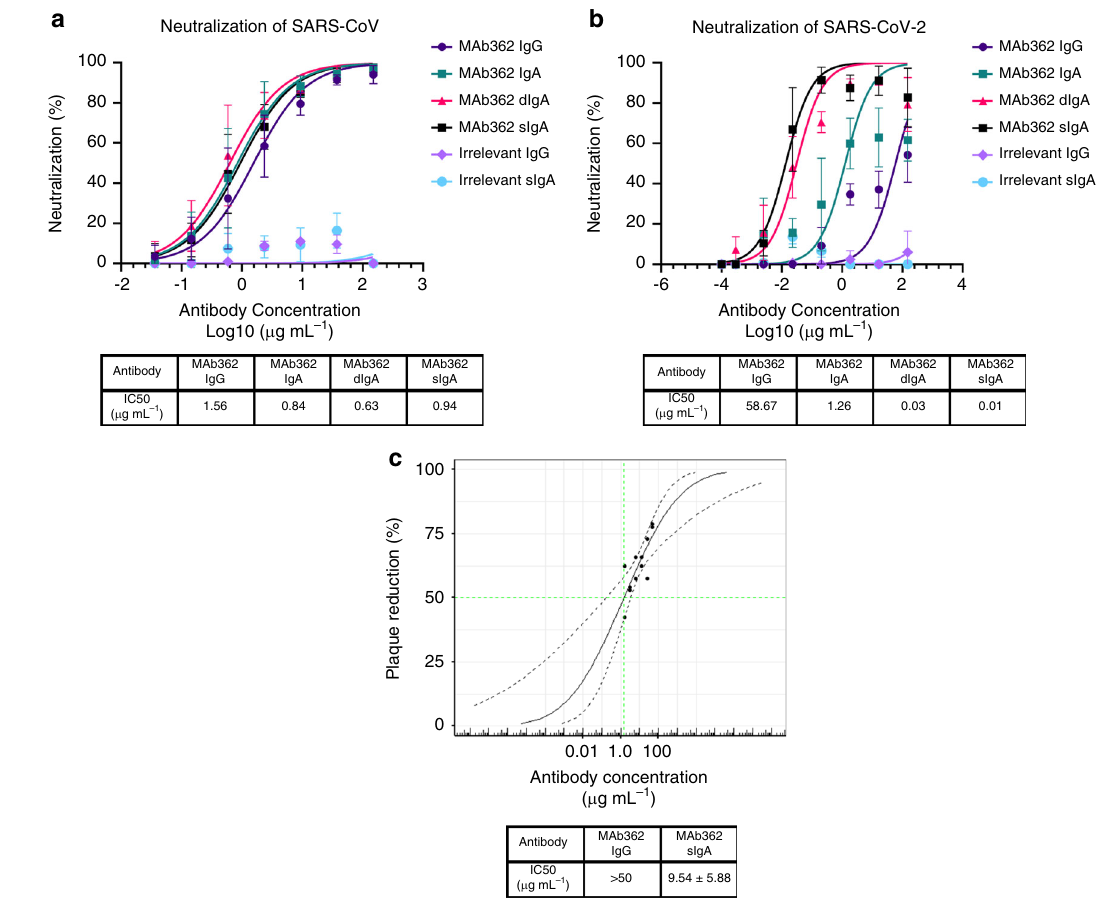
Fig. 4 IgA isotype switch enhances MAb362 neutralization of SARS-CoV-2. MAb362 antibody-mediated neutralization of luciferase-encoding pseudovirions with spike proteins of SARS-CoV a and SARS-CoV-2 b . SARS-CoV and SARS-CoV-2 pseudovirions pre-incubated with serial dilutions of MAb362 were used to infect 293 cells expressing ACE2 receptor. Pseudoviral transduction was measured by luciferase activities in cell lysates 48h post transduction to calculate neutralization (%) relative to non-antibody-treated controls. IC 50 values were calculated by nonlinear regression analysis using Prism version 8.1.1. Isotype switching improved SARS-CoV-2 IC50. Data are plotted as the mean ± s.d. from n = 3 independent experiments a , b . c Dose –